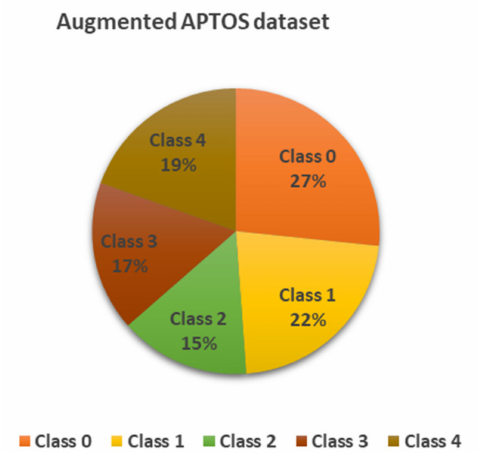
Figure 3. Augmented APTOS dataset.